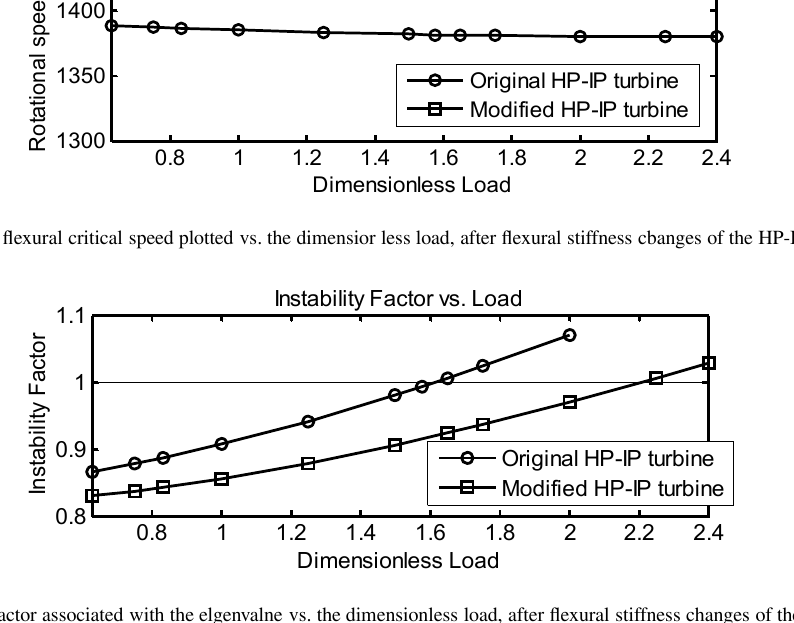
Fig. 24. Instability factor associated with the elgenvalne vs. the dimensionless load, after fl exural stiffness changes of the HP-IP trubine. those obtained in the same conditions by means of the original model of the shaft-train. The small increase of